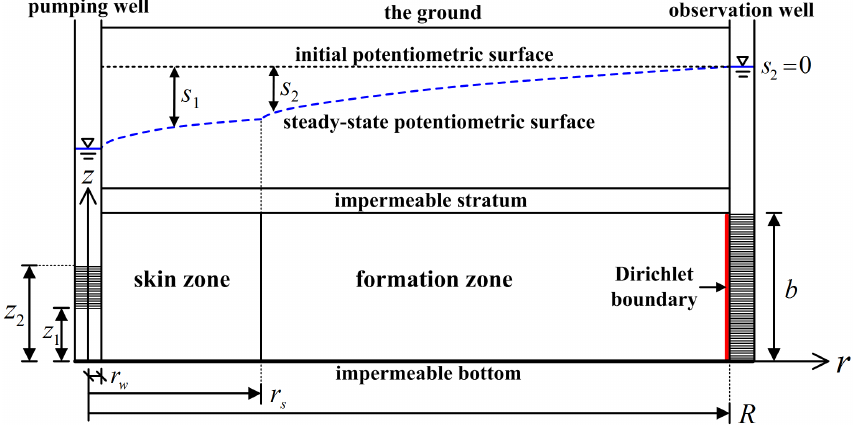
Figure 1. A schematic diagram of the constant-flux pumping at a partially penetrating well in a cylinder two-zone confined aquifer with the Dirichlet boundary. (The symbols of the variables are defined in Table